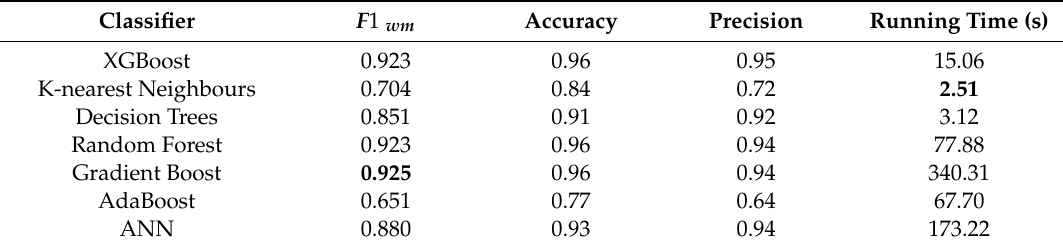
Table 3. Comparisons between XGBoost and other